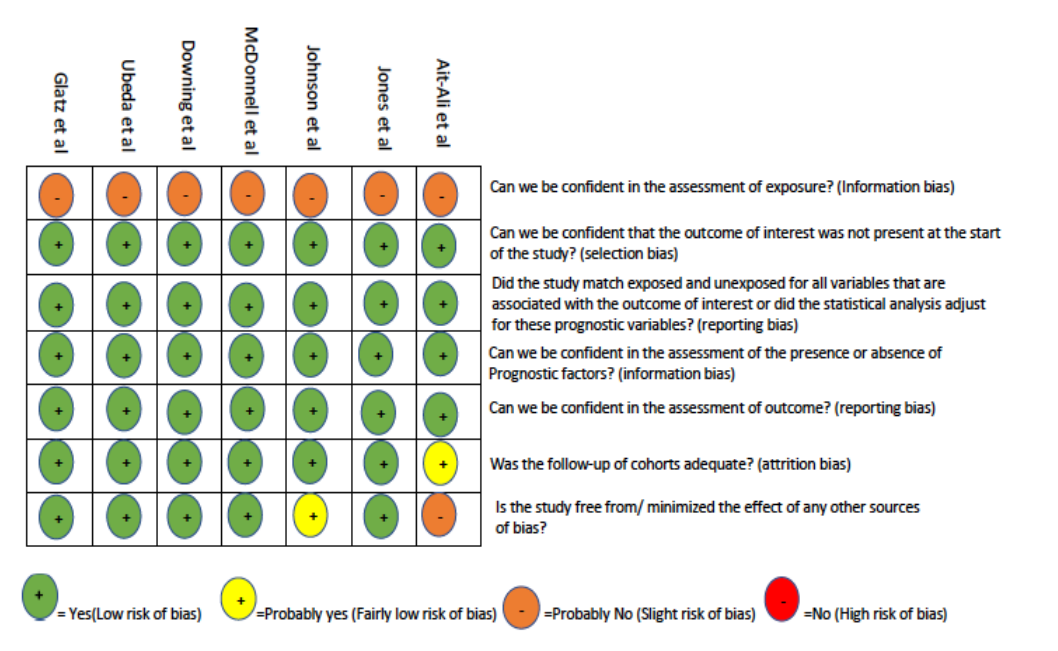
Figure 2. Risk of bias [22–28]. Table 1. Summary of included studies and cumulative effective radiation.